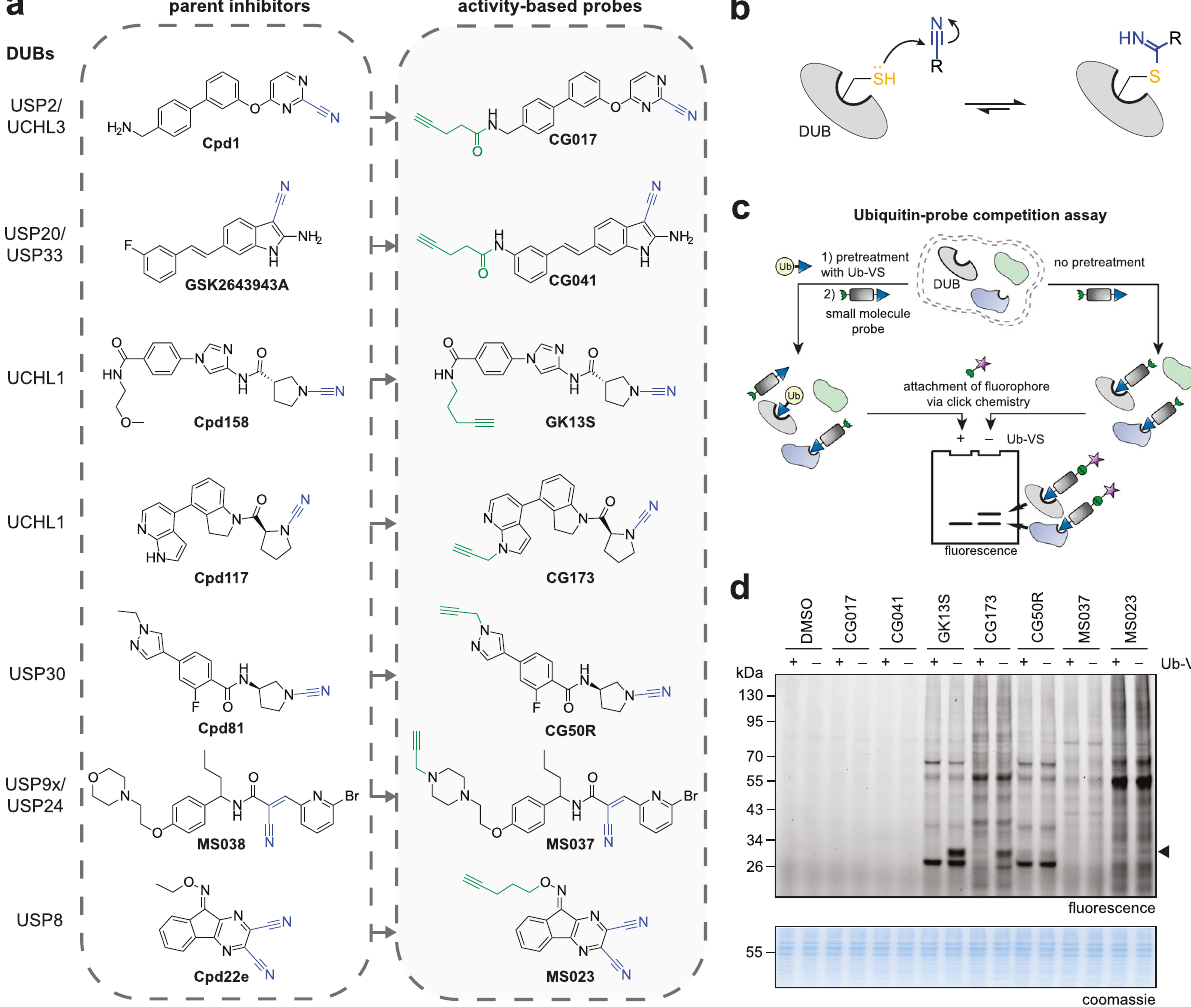
moleculeprobetreatment(leftpath)ortreatedwiththesmallmoleculeprobeonly (right path), in order to indicate whether small molecule probe-modi fi ed proteins are DUBs. d Activity-based protein pro fi ling in HEK293 cell lysate with indicated compounds(1 µ M,1h).ProteomeswerepretreatedwithUb-VSprobewhereshown. TheblackarrowindicatesaUb-VScompetitive proteintargetinGK13S-andCG173- treated samples. Uncropped versions of gels are shown in the supplementary